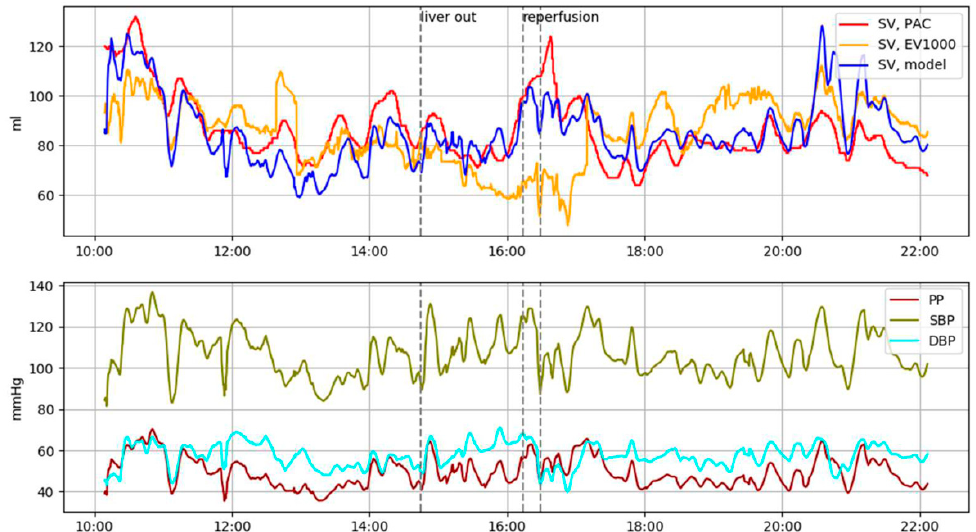
Figure 2. Representative plot of intraoperative tracking of stroke volume (SV) trends of Vigilance, EV1000 and proposed method during liver transplantation surgery. Note that proposed method (blue) shows a similar trend to Vigilance (red), while EV1000 (orange) fails to follow SV trend especially during the before and after the reperfusion phase (15:30–17:00).